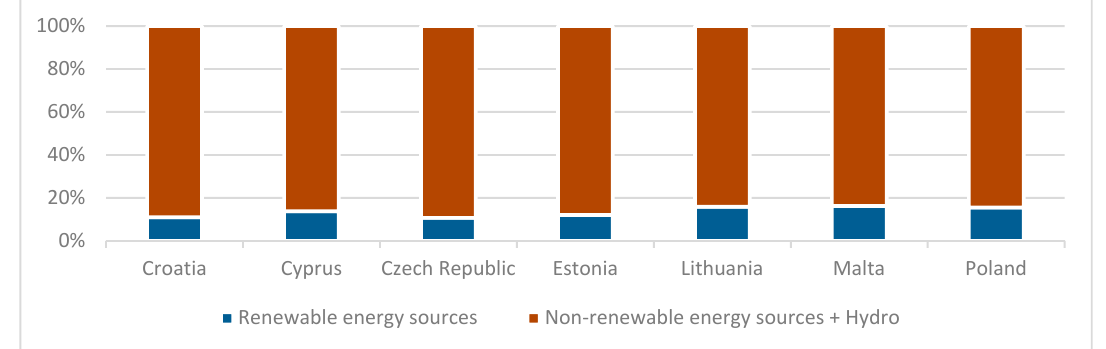
Figure 17. Energy sources in the countries of group B in 2016.